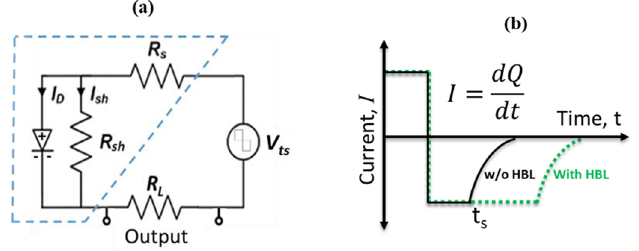
Fig. 2. Schematics of (a) the circuit diagram and (b) T rr current for devices with and without